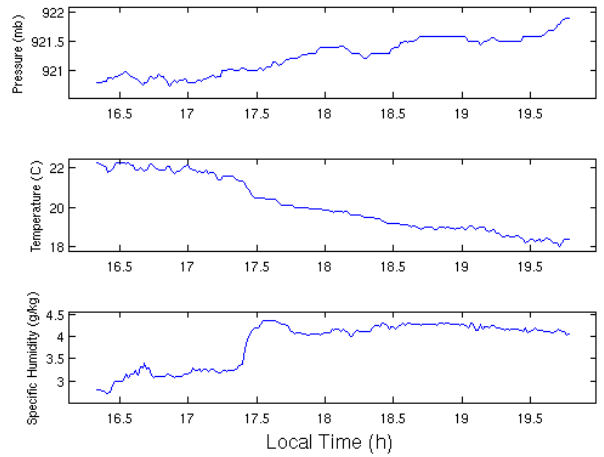
Fig. 4. The atmospheric pressure, temperature and specific humid- ity measured at the PAS building during the ATOMMS rooftop tests on 13 March